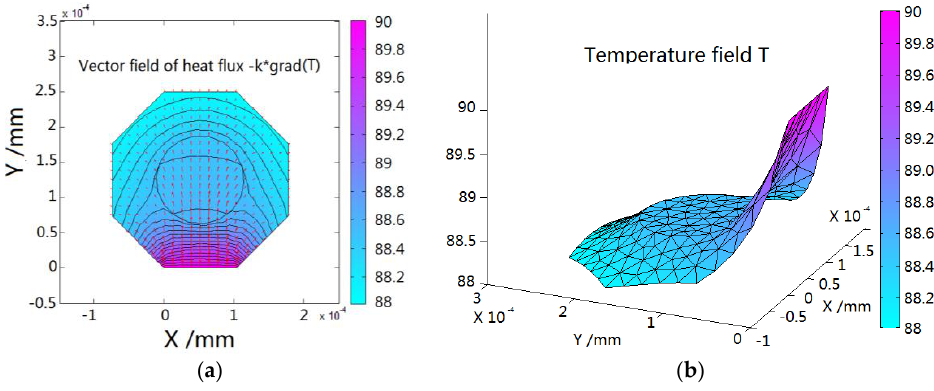
Figure 3. ( a ) Heat flux and ( b ) temperature field on optical fiber cross-section.